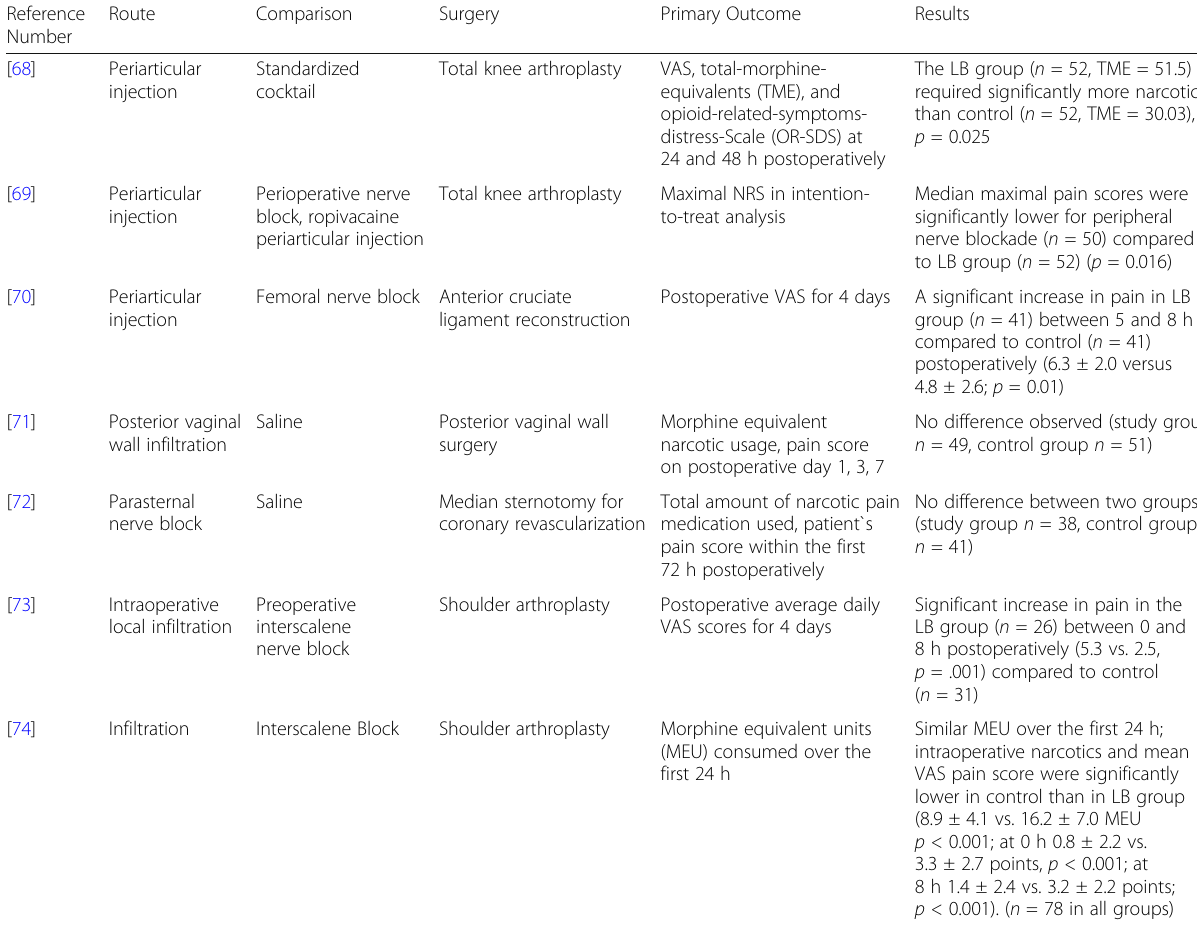
Table 3 Summary of researches with negative efficacy of EXPAREL Reference